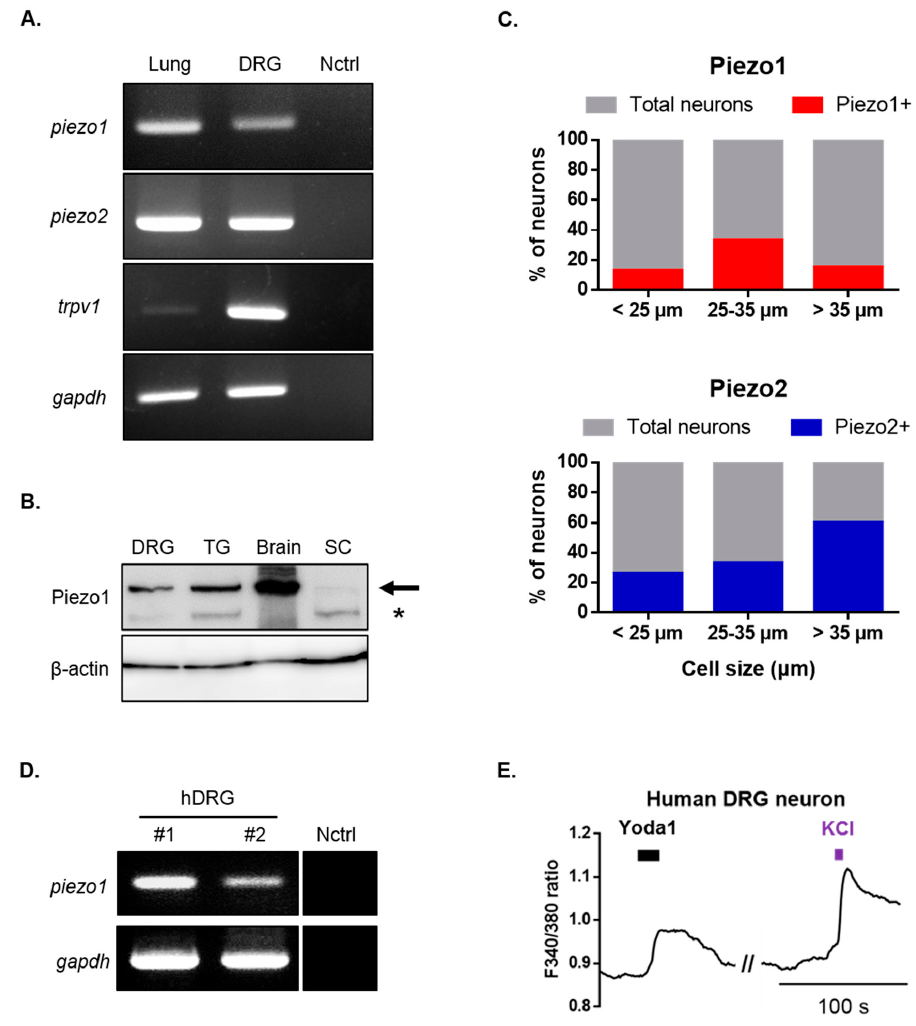
Figure 2. Identification of Piezo1 expression in mouse and human dorsal root ganglion (DRG) neurons. ( A ) RT-PCR showing piezo1, piezo2, trpv1 and gapdh mRNA expression in mouse DRG and lung tissue ( piezo1 and piezo2 positive control). Primer and ultrapure water were used as negative controls. ( B ) Western blot showing Piezo1 protein expression in mouse DRG, trigeminal ganglion (TG), whole brain, and spinal cord (SC). The upper bands which are indicated by arrow represent Piezo1. Second bands (*) is nonspecific. ( C ) Single-cell RT-PCR of mouse DRG neurons showing % of piezo1 and piezo2 mRNA expressing neurons. ( D ) RT-PCR showing piezo1 gene expression in two di ff erent human’s DRG (human primer and ultrapure water were used as negative controls). ( E ) Application of Yoda1 (10 µ M, 10 s)-induced Ca 2 + response in human DRG neurons. High potassium chloride (50 mM) is a neuronal marker. DRG: dorsal root ganglion; Nctrl: negative control; RT-PCR: reverse transcription-polymerase chain reaction; SC: spinal cord; TG: trigeminal ganglion; hDRG: human DRG. 2.3. Pharmacological Inhibition of Piezo1 in Mouse Dorsal Root Ganglion (DRG)